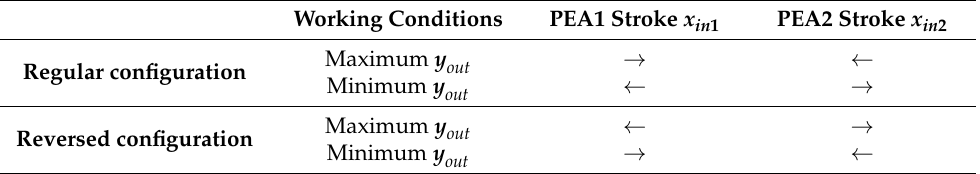
Table 2. Typical working